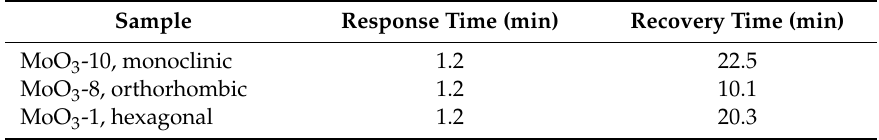
Table 3. Response and return times of sensors using 25,000 ppm H 2